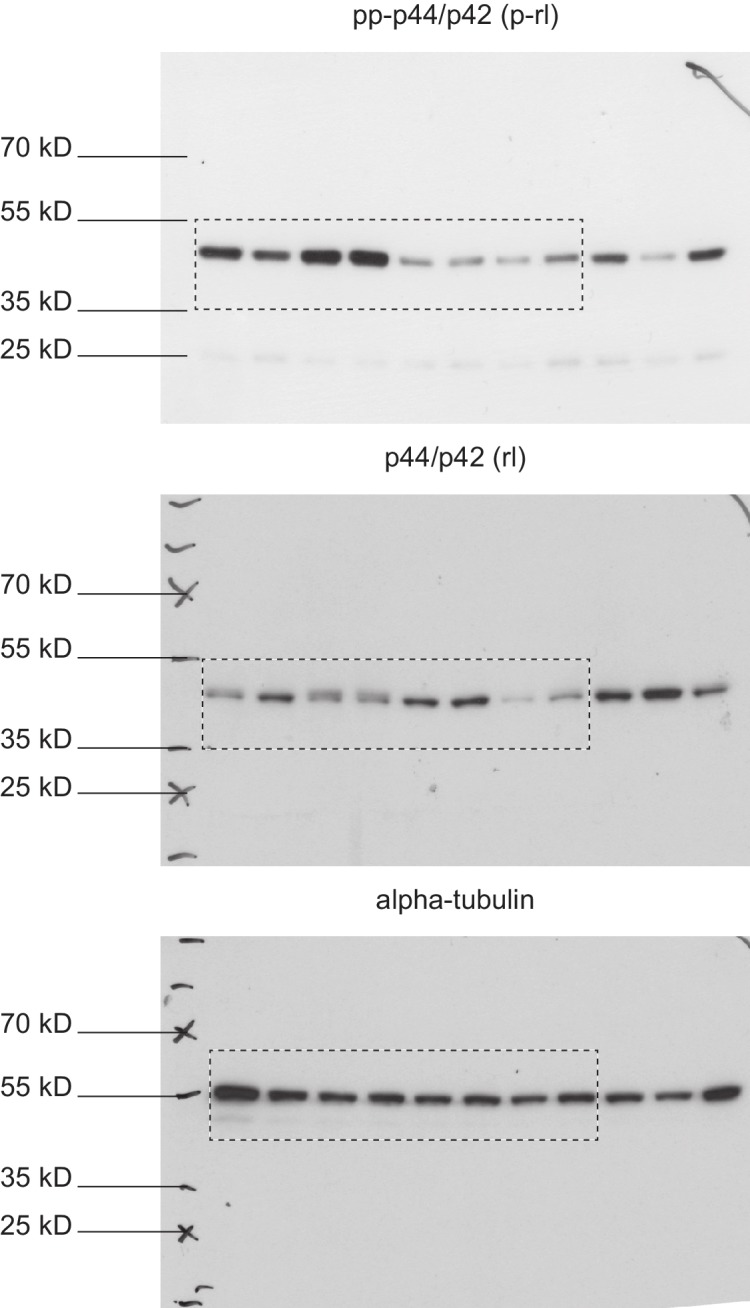
Full immunoblots.Full, un-edited immunoblots accompanying (Figure 8—figure supplement 4). Areas that were cut are indicated. Raw scans of developed Amersham hyperfilms (GE-Healthcare). Exposure times varied from 3 s to 10 s. Membranes were stripped and re-probed for total-rolled and α-tubulin after each development.